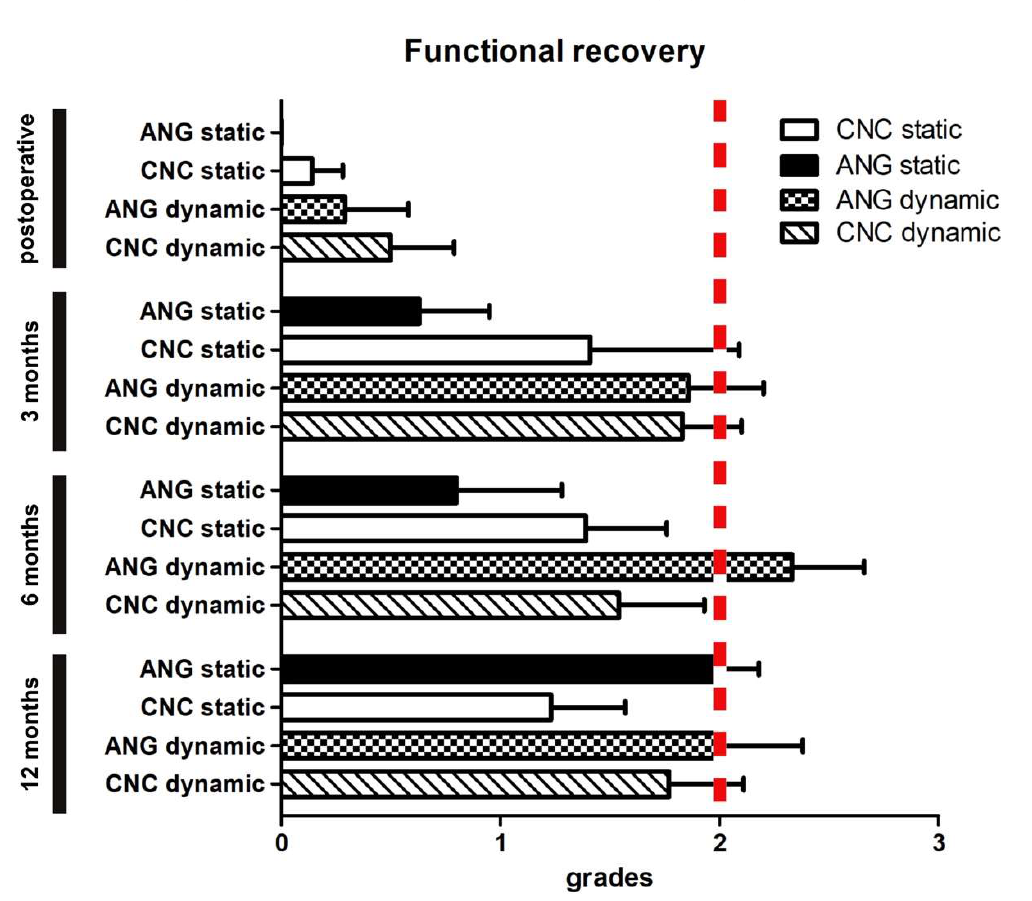
Figure 4. Direct comparison of ANG and CNC focusing on functional recovery. Categorizing the two-point discrimination showed that meaningful regeneration is shown after twelve months by the ANG and nearly similar for CNC. Interestingly, dynamic regeneration showed superior results to static analysis focusing on functional recovery.